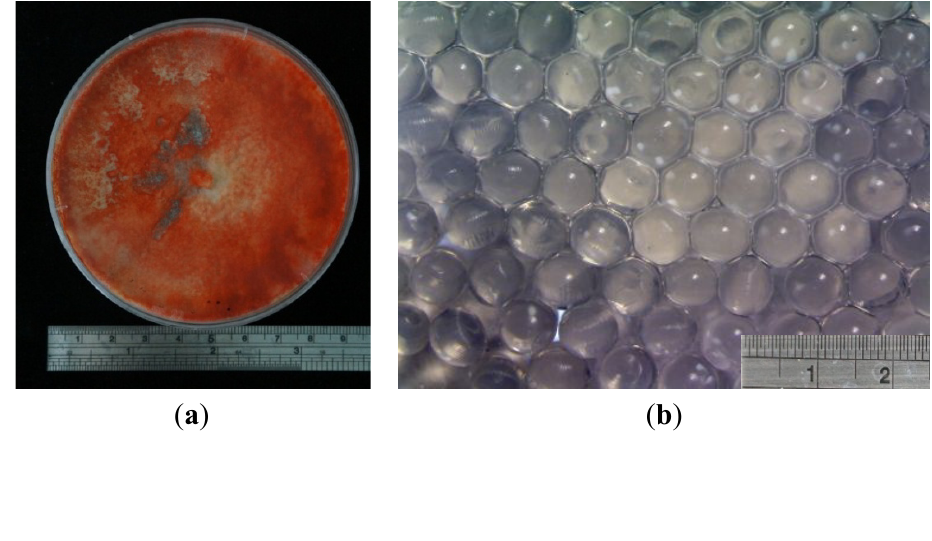
Figure 2. Optical microscopy images of ( a ) P. sanguineus in a dish, ( b ) alginate beads, ( c ) P. sanguineus -loaded alginate beads, ( d ) P. sanguineus -loaded alginate beads with magnetic iron oxide nanoparticles (e.g., magnetic P. sanguineus -loaded alginate